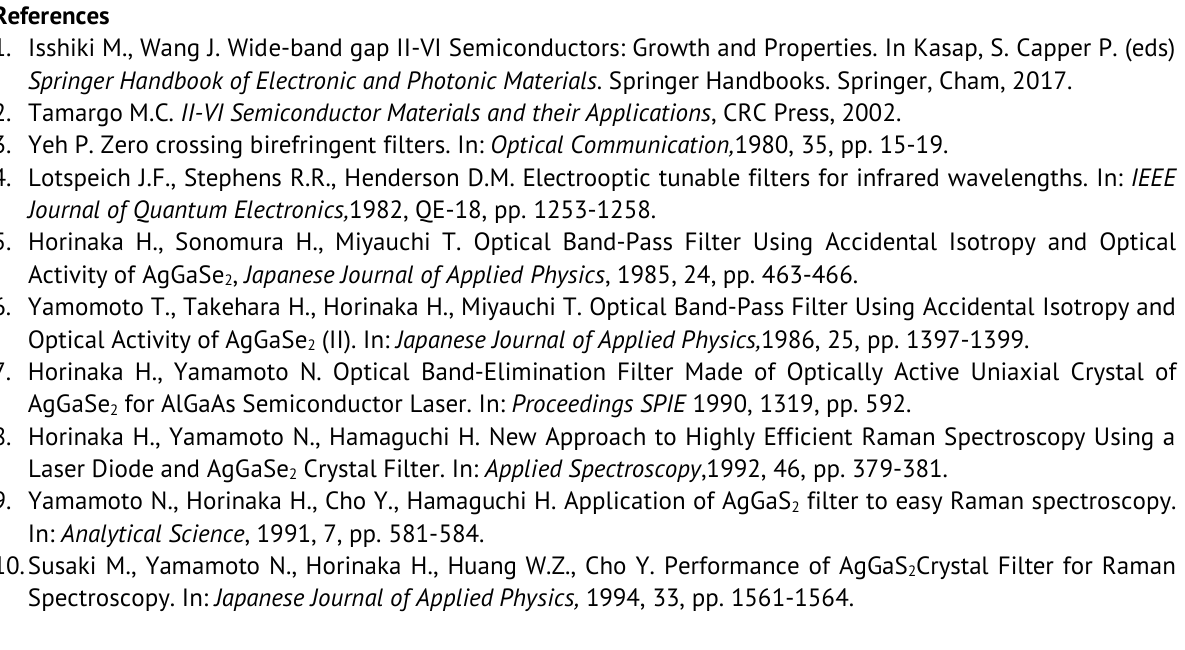
crystals with thicknesses of 223 µm in crossed 2